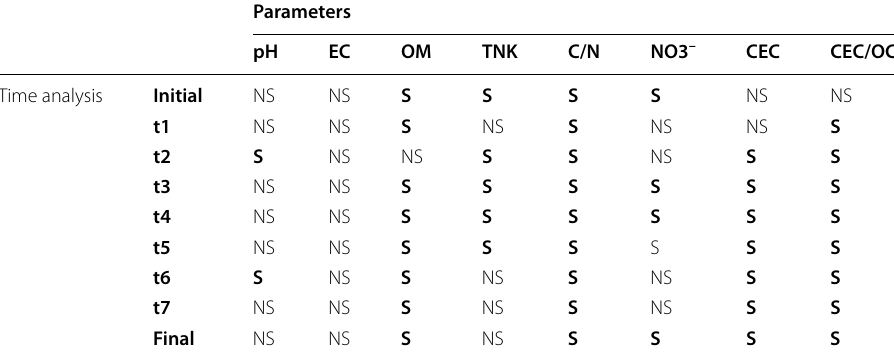
NS non‑significant variability, S significant variability